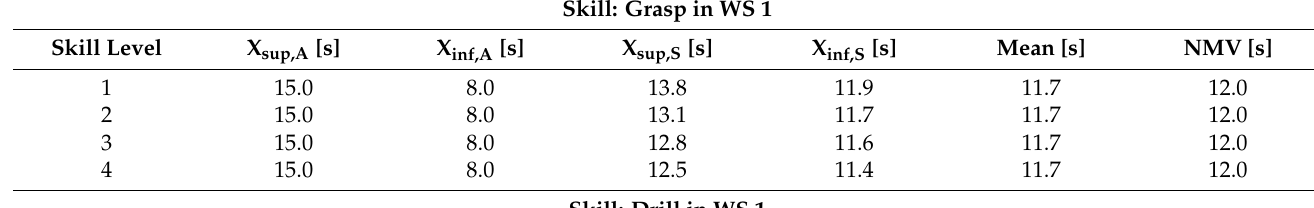
Table 5. Summary if the intervals of the graphs considered in Figures 13–19. Skill: Grasp in WS